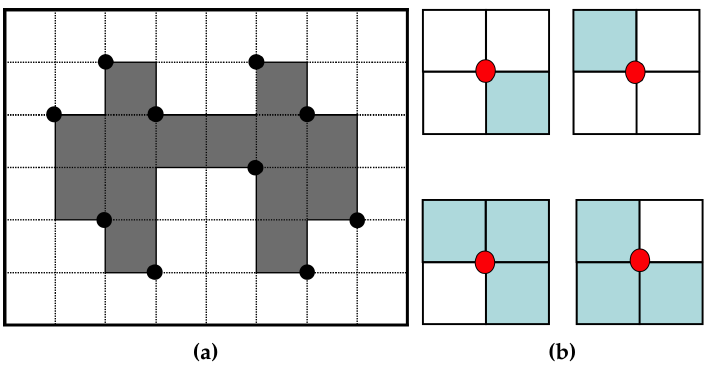
Figure 7. Representative points for data compression. ( a ) Representative points [17]; ( b ) cases of representative